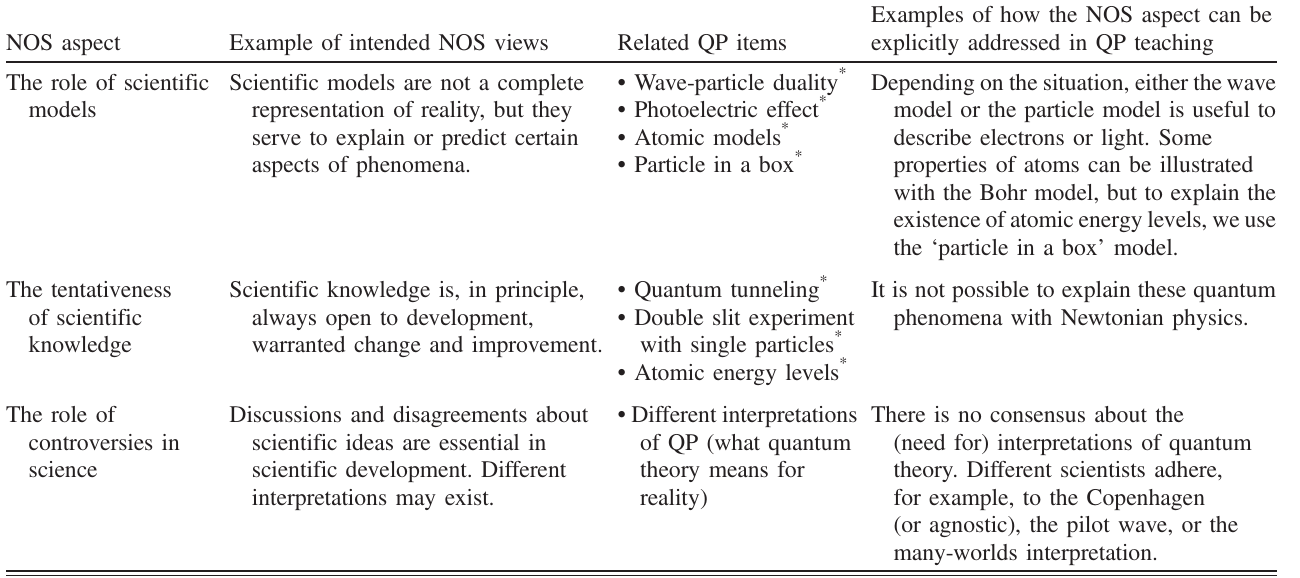
TABLE I. Examples of connections between NOS and QP content for teaching. NOS